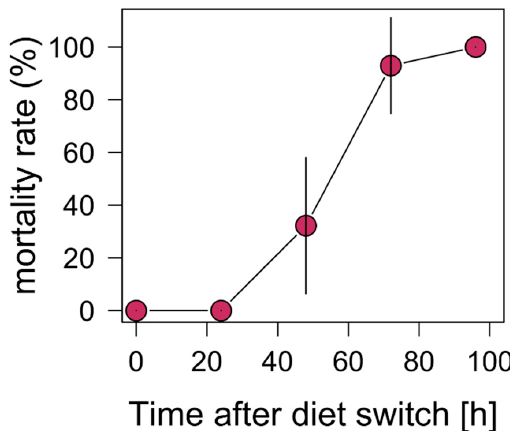
Figure 1. Mortality rate (%) for D. magna with the M. aeruginosa dietary treatment over a time period of 96 h following the dietary switch.